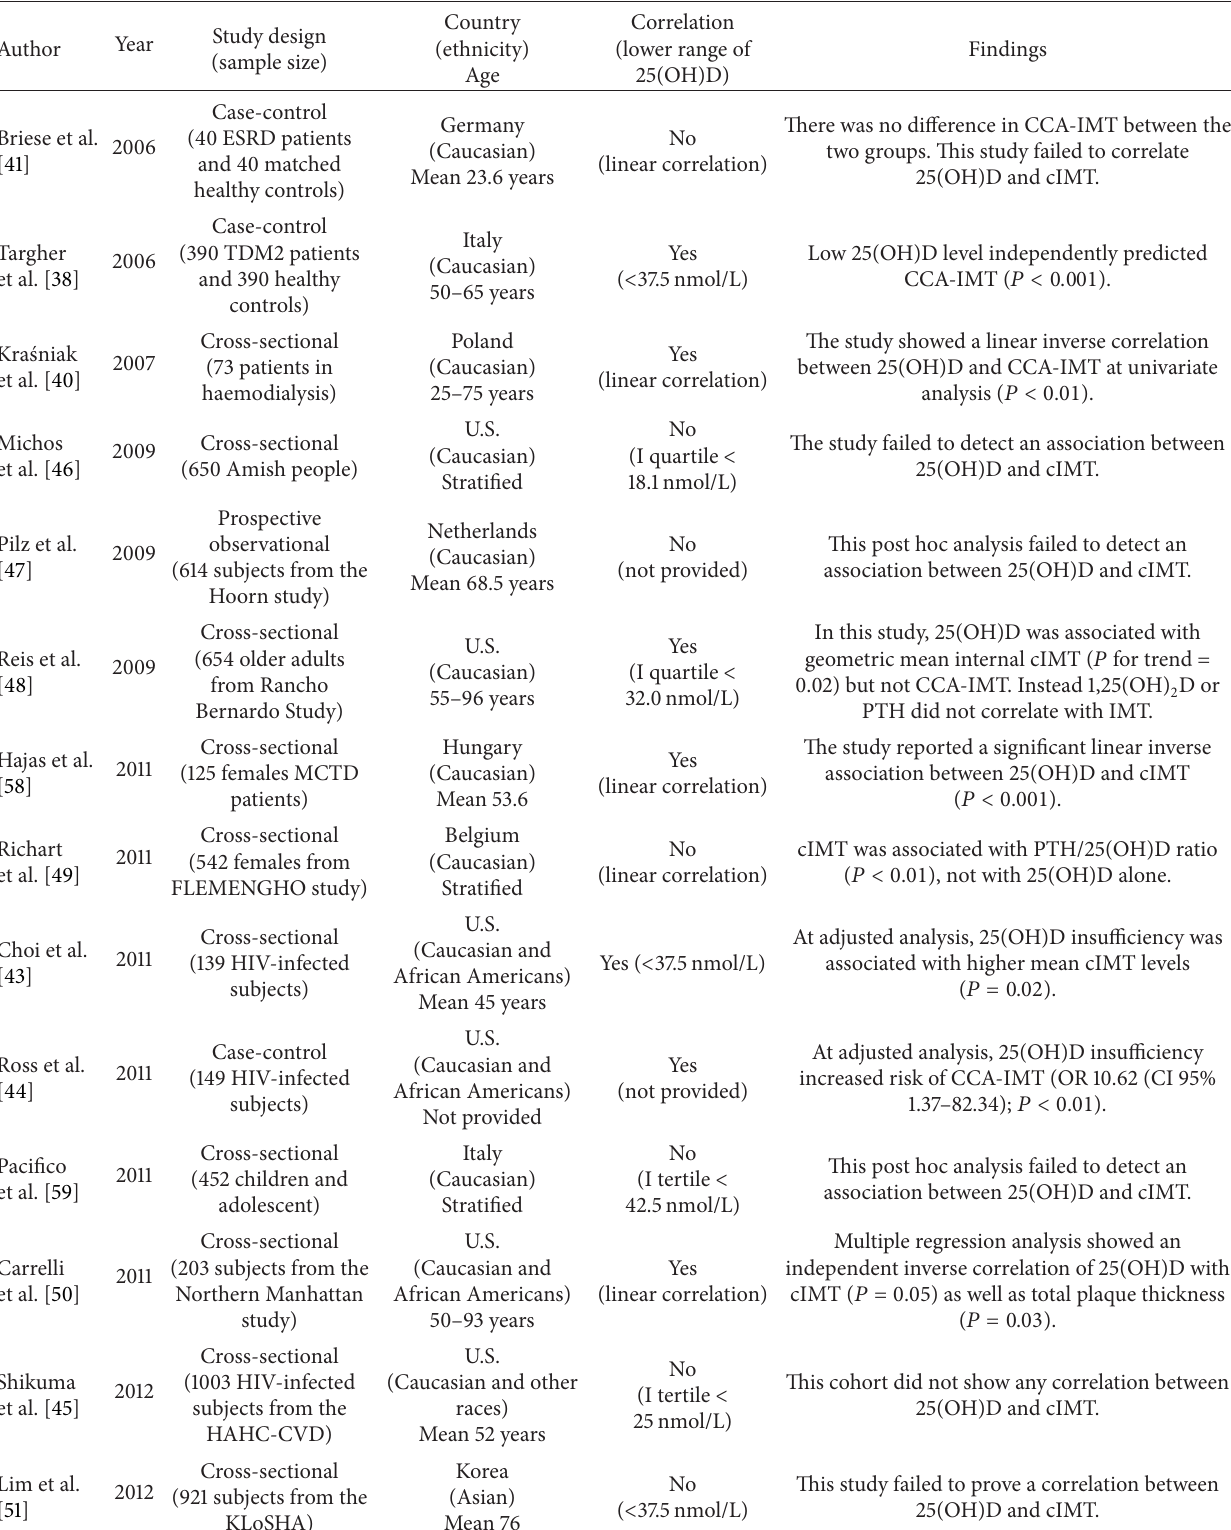
Table 1: Observational studies investigating the relationship between vitamin D and carotid intima-media